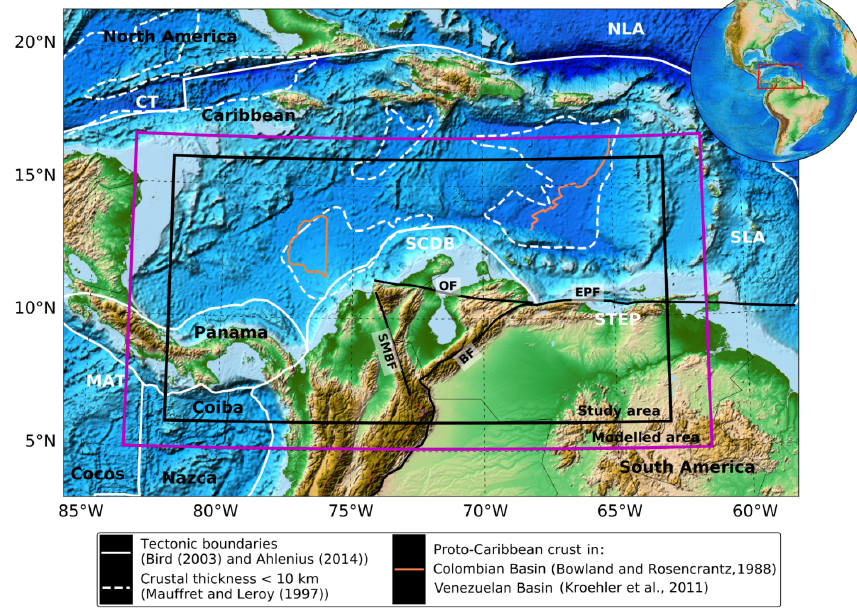
Figure 1. Location of the regions for models (magenta box) and interpretations (black box). The modelled area involves four tectonic plates: Caribbean, Panama, Nazca (Coiba microplate), and the north of South American plate. Black lines represent the main faults. BF is the Boconó Fault, CB is the Colombian Basin, CT is the Cayman Trough, EPF is the El Pilar Fault, NLA is the northern Lesser Antilles subduction, MAT is the Middle American Trench, OF is the Oca Fault, SCDB is the South Caribbean Deformed Belt, SLA is the southern Lesser Antilles subduction, SMBF is the Santa Marta-Bucaramanga Fault, STEP is the Subduction–Transform–Edge–Propagator fault system, and VB is the Venezuelan Basin. Shade relief image from Amante and Eakins